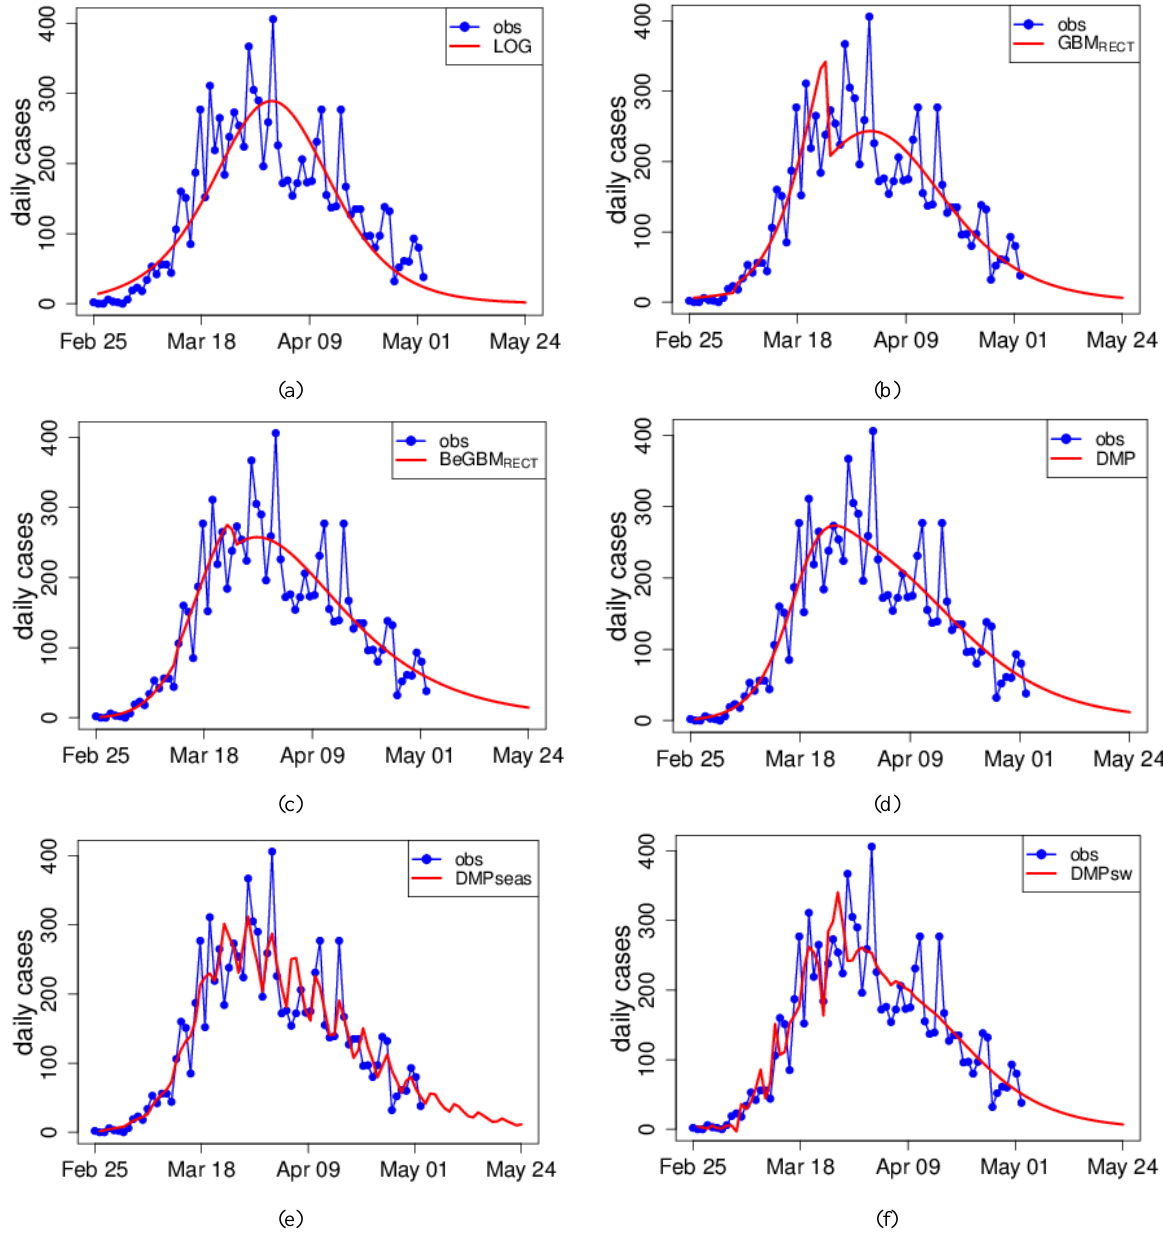
Figure 8. Tuscany. Observed and fitted values with the alternative models. (a) Logistic (LOG); (b) GBM with rectangular shock (GBM 𝑹𝑬𝑪𝑻 ); (c) Bemmaor GBM with rectangular shock (BeGBM 𝑹𝑬𝑪𝑻 ); (d) Dynamic market potential (DMP); (e) Dynamic market potential+seasonal effect (DMPseas); (f) Dynamic market potential+swabs (DMPsw). Table 7. Tuscany. Estimates, asymptotic standard errors and 95% mCIs for the parameters of the DMPsw (9)+(11). Parameter Estimate Standard